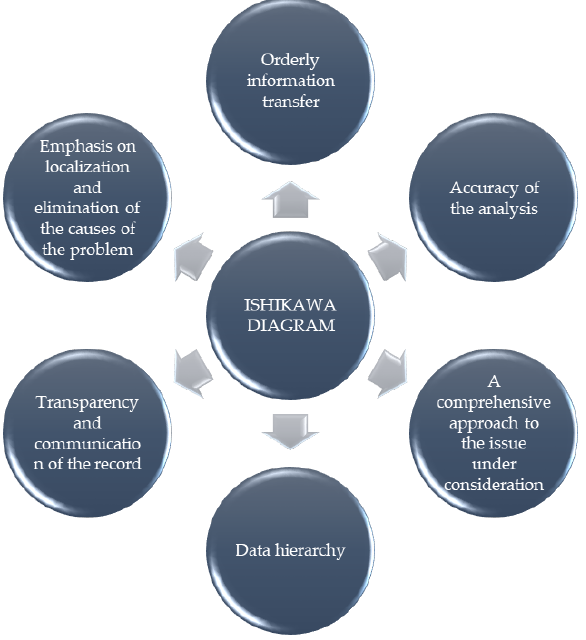
Figure 3. Features of the Ishikawa diagram. Own study based on [62].